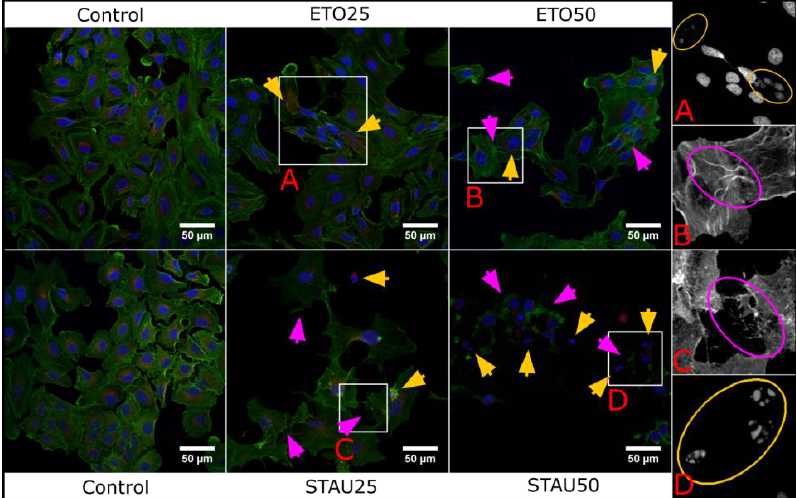
Figure 16. Morphological changes induced by Eto and Stau in A549 cell line at IC25 and IC50. Yellow arrows indicate nuclear fragmentation/damage and magenta arrows show cytoskeleton degradation. The panel in the right presents single channel regions of interest to highlight the structural features in a more detailed manner.